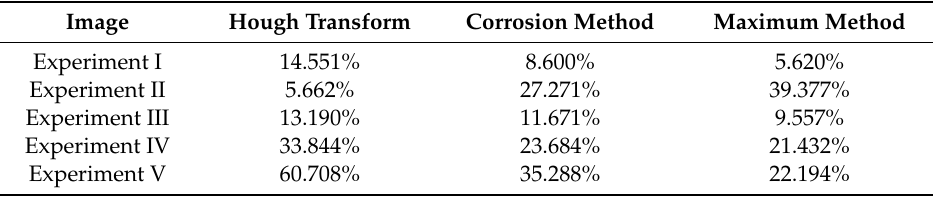
Figure 8. Comparison of overlapped apples localization by Hough transform, corrosion method and maxima method. ( a ) Hough transform; ( b ) corrosion method; ( c ) maximum method. Table 1. Four methods’ area relative